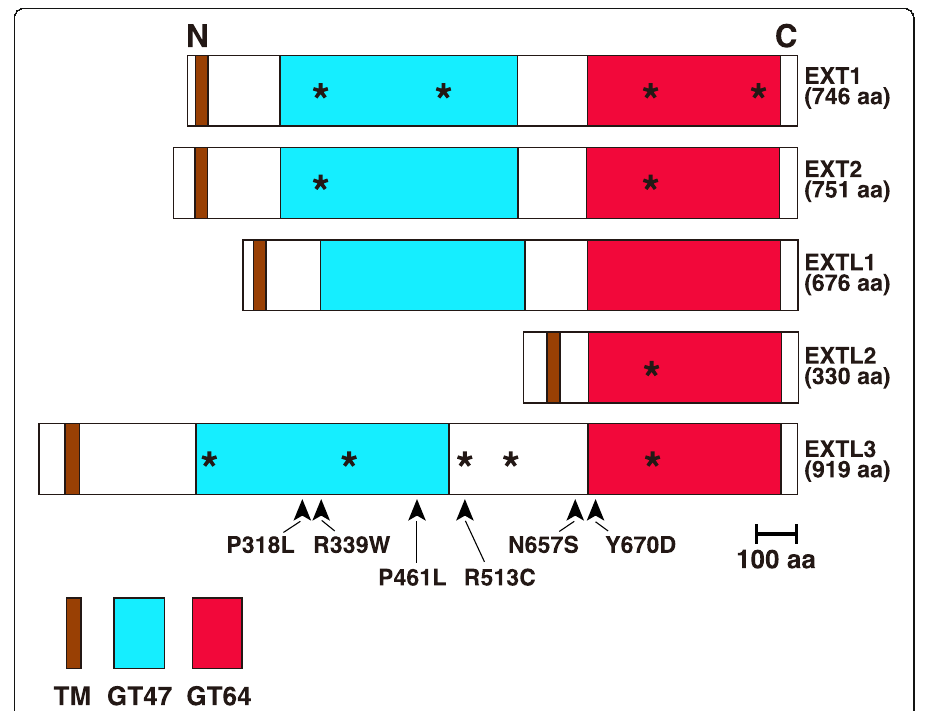
Fig. 2 Schematic representation of human EXT family members. All are single-pass transmembrane proteins with a type II topology. They have short cytoplasmic, transmembrane (TM) and long Golgi luminal regions. Apart from EXTL2, two predicted glycosyltransferase domains belonging to glycosyl transferase family 47 (GT47) and GT64 are present. The former and latter are presumed to exhibit the enzymatic activities of GlcAT-II and GlcNAcT-II, respectively. EXTL2 is the shortest among the EXT family members, and only has the GT64 domain in the luminal region. Although EXTL3 exhibits GlcNAcT-I and GlcNAcT-II activities, but not GlcAT-II activity, it currently remains unclear whether the GT47 domain exhibits GlcNAcT activities. DXD (Asp-X-Asp) motifs in amino acid sequences are shown as asterisks, which are important for glycosyltransferases to interact with a Mn 2+ cofactor that stabilizes binding of the diphosphate moiety of the UDP-sugars substrate. Arrowheads indicate the sites of mutations found in human genetic diseases (see Table